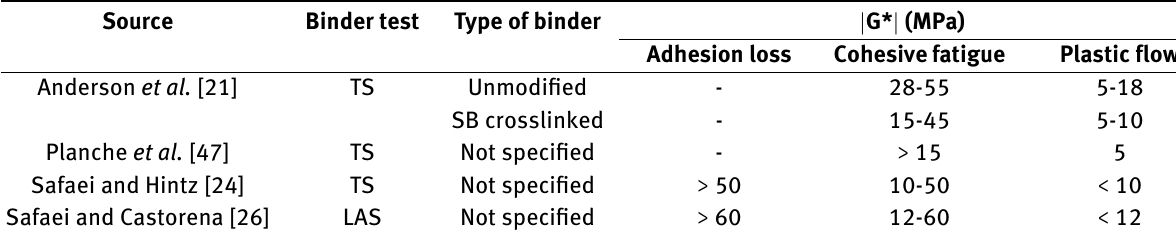
Table 4: Summary of | G* | range recommendation for different failure mechanisms Source Binder test Type of